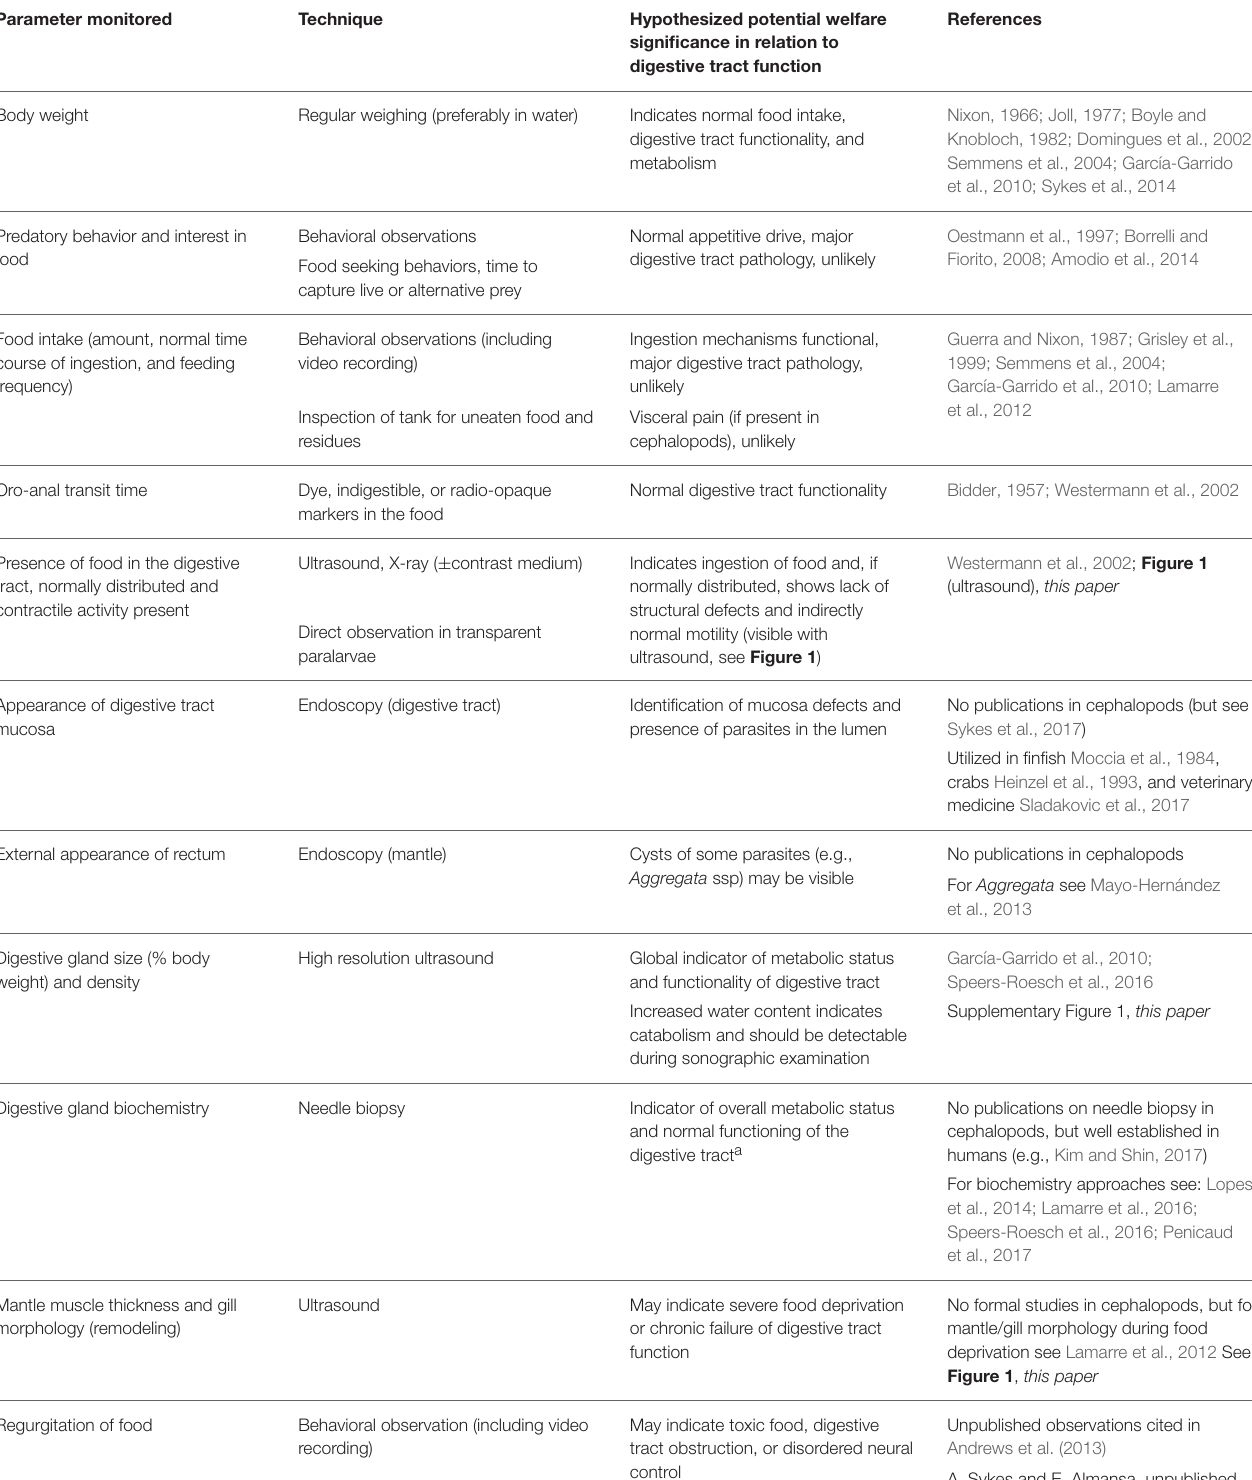
TABLE 1 | Summary of parameters that could be used to monitor cephalopod digestive tract functioning by non-invasive or minimally invasive techniques to provide either a direct or indirect insight into the physiology of the digestive tract. Examples are taken mainly from studies on S. officinalis or Nautilus pompilius and/or octopus (mostly O. vulgaris), but all techniques appear equally applicable to